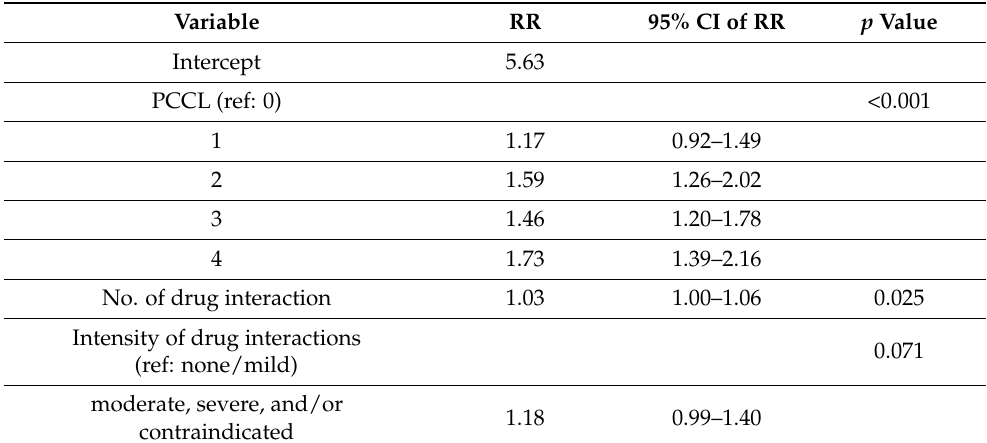
Table 3. Association between hospital LOS and various factors for patients aged 80 years and older by regression